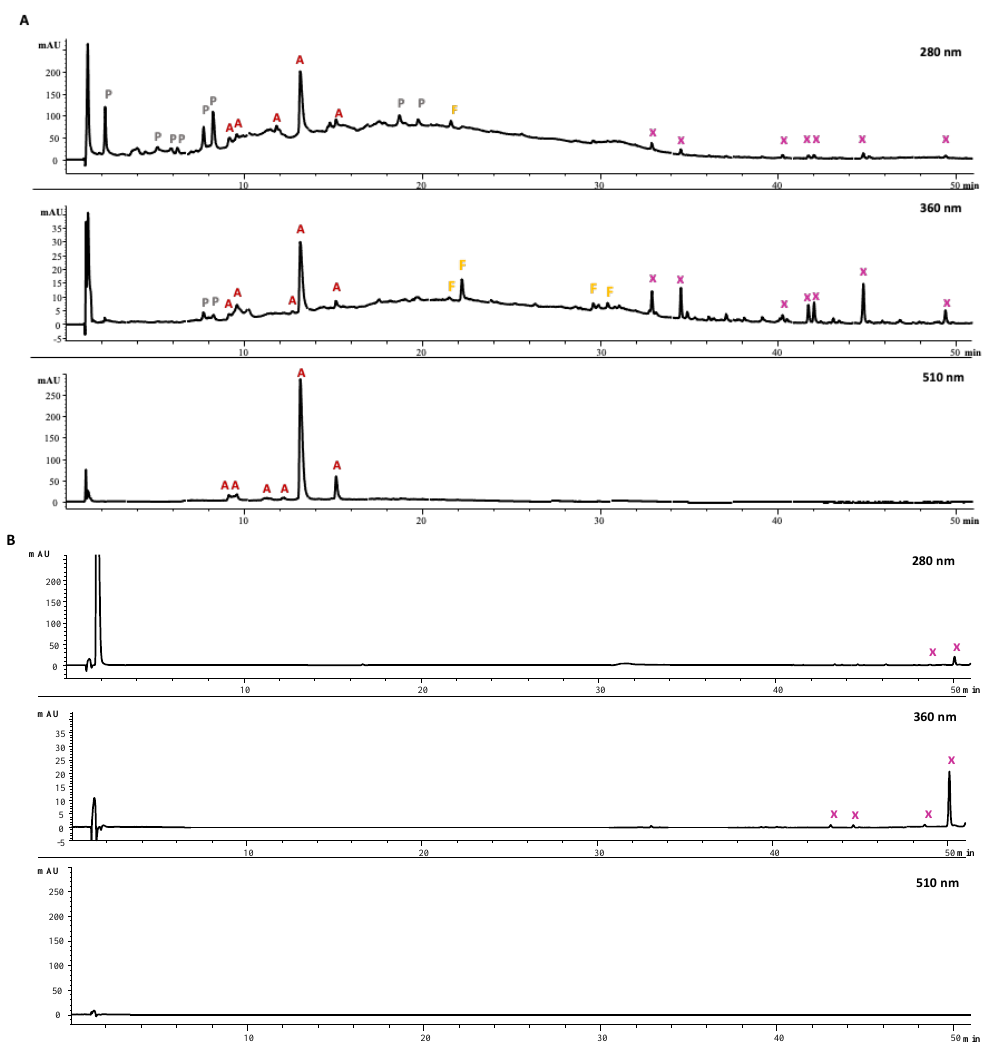
Figure 4. HPLC-DAD chromatograms at 280, 360, and 510 nm corresponding to the analyses of the NEPs and EPPS of extracts obtained by the optimal UAE-NaDES (ChCl:LA, 1:2) method (60% ultrasound amplitude, 18.8% water percentage, and 15 min extraction time) ( A ) and the conventional extraction method ( B ), respectively, from mangosteen peel. P: phenolic compound; X: xanthones; F: flavonols; and A: anthocyanins.